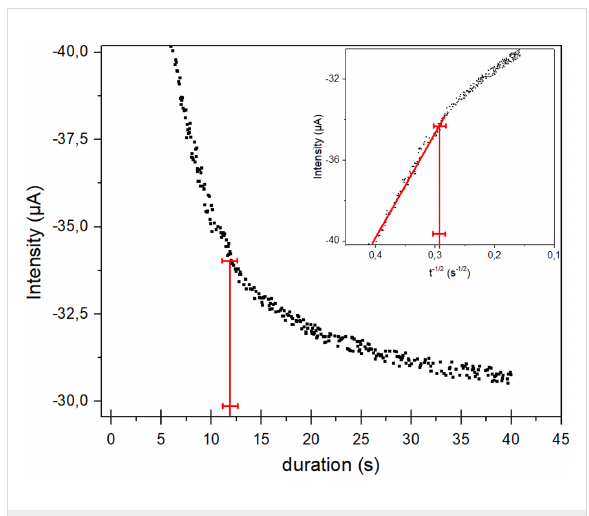
Figure 2: Variation of the current reduction ( i 2 ) of SF 6 onto Pt macro- electrode (Ø = 0.76 mm) at − 2.3 V vs Fc + /Fc in acetonitrile freshly distilled after addition of TBAClO 4 (0.1 M) at room temperature, under slight argon stream. Insert figure: Determination of the upper limit on time of Cottrell law from the straight line i 2 = f( t − 1/2